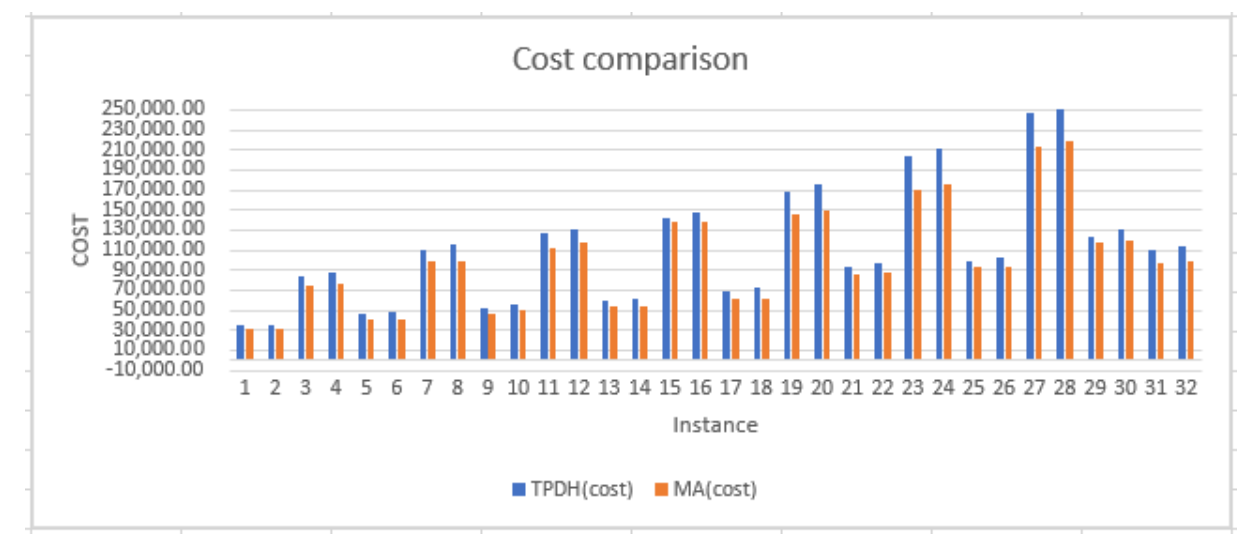
Figure 2. Overall cost comparison.